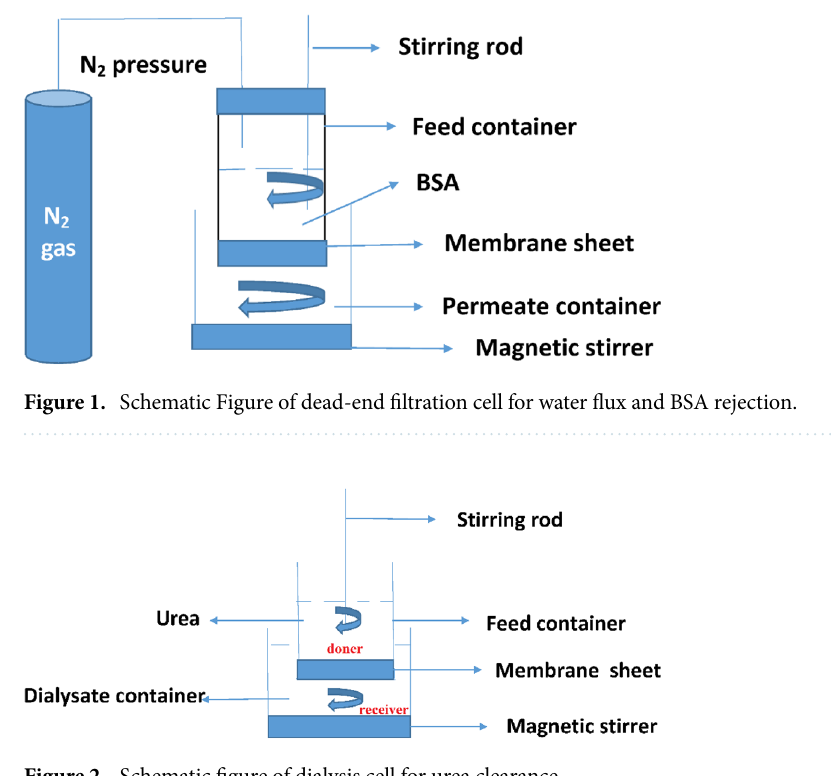
Figure 2. Schematic figure of dialysis cell for urea